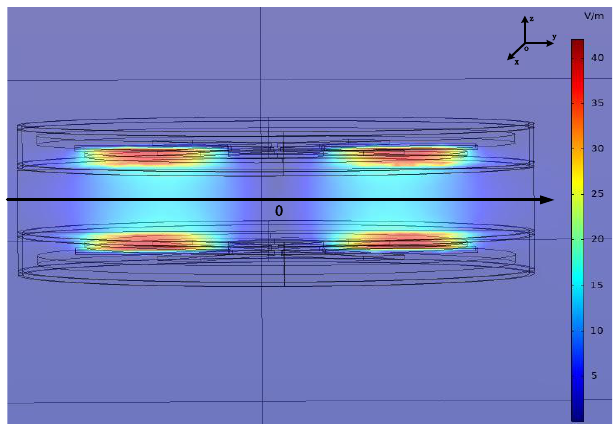
Figure 8. yoz plane electric field